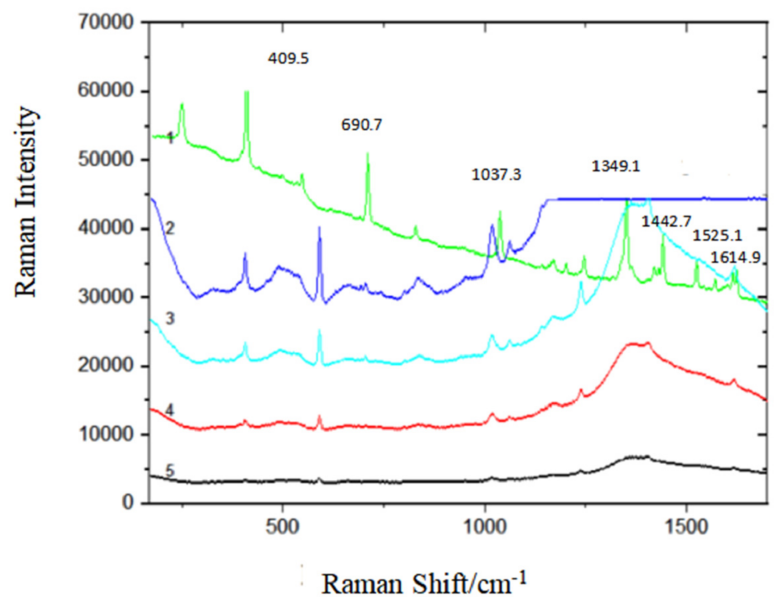
Figure 8. The detection limit of phenanthrene captured on Fe 3 O 4 @PDA@Ag@GO nanocomposites SERS substrate (1) phenanthrene solid; (2) 10 − 5 g/L phenanthrene SERS solution; (3) 10 − 6 g/L phenanthrene SERS solution; (4) 10 − 7 g/L phenanthrene SERS solution; (5) 10 − 8 g/L phenanthrene SERS solution.